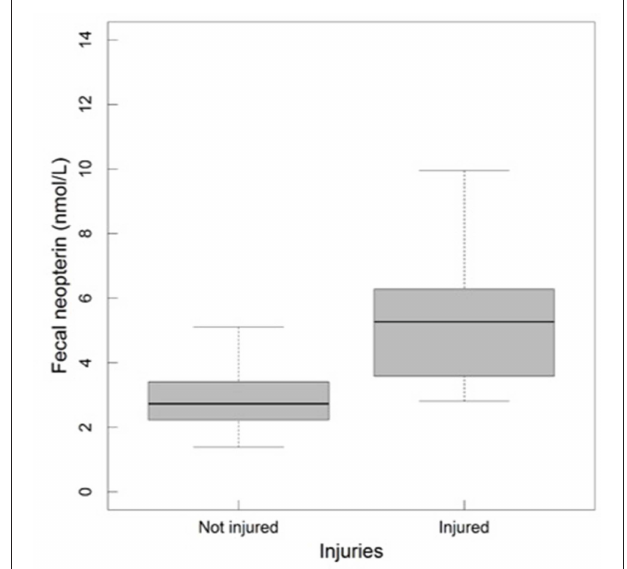
FIGURE 5 | Fecal neopterin concentrations (raw data) in relation to injuries in adult males ( N = 13 individuals and 113 samples including 102 samples from the category not injured and 11 from the category injured; mean number of samples per male ± SD: 8.7 ± 10.1; range: 1–31). The bottom and top of the box, respectively, represent the 25th and 75th quartiles, and the bold horizontal line represents the median.